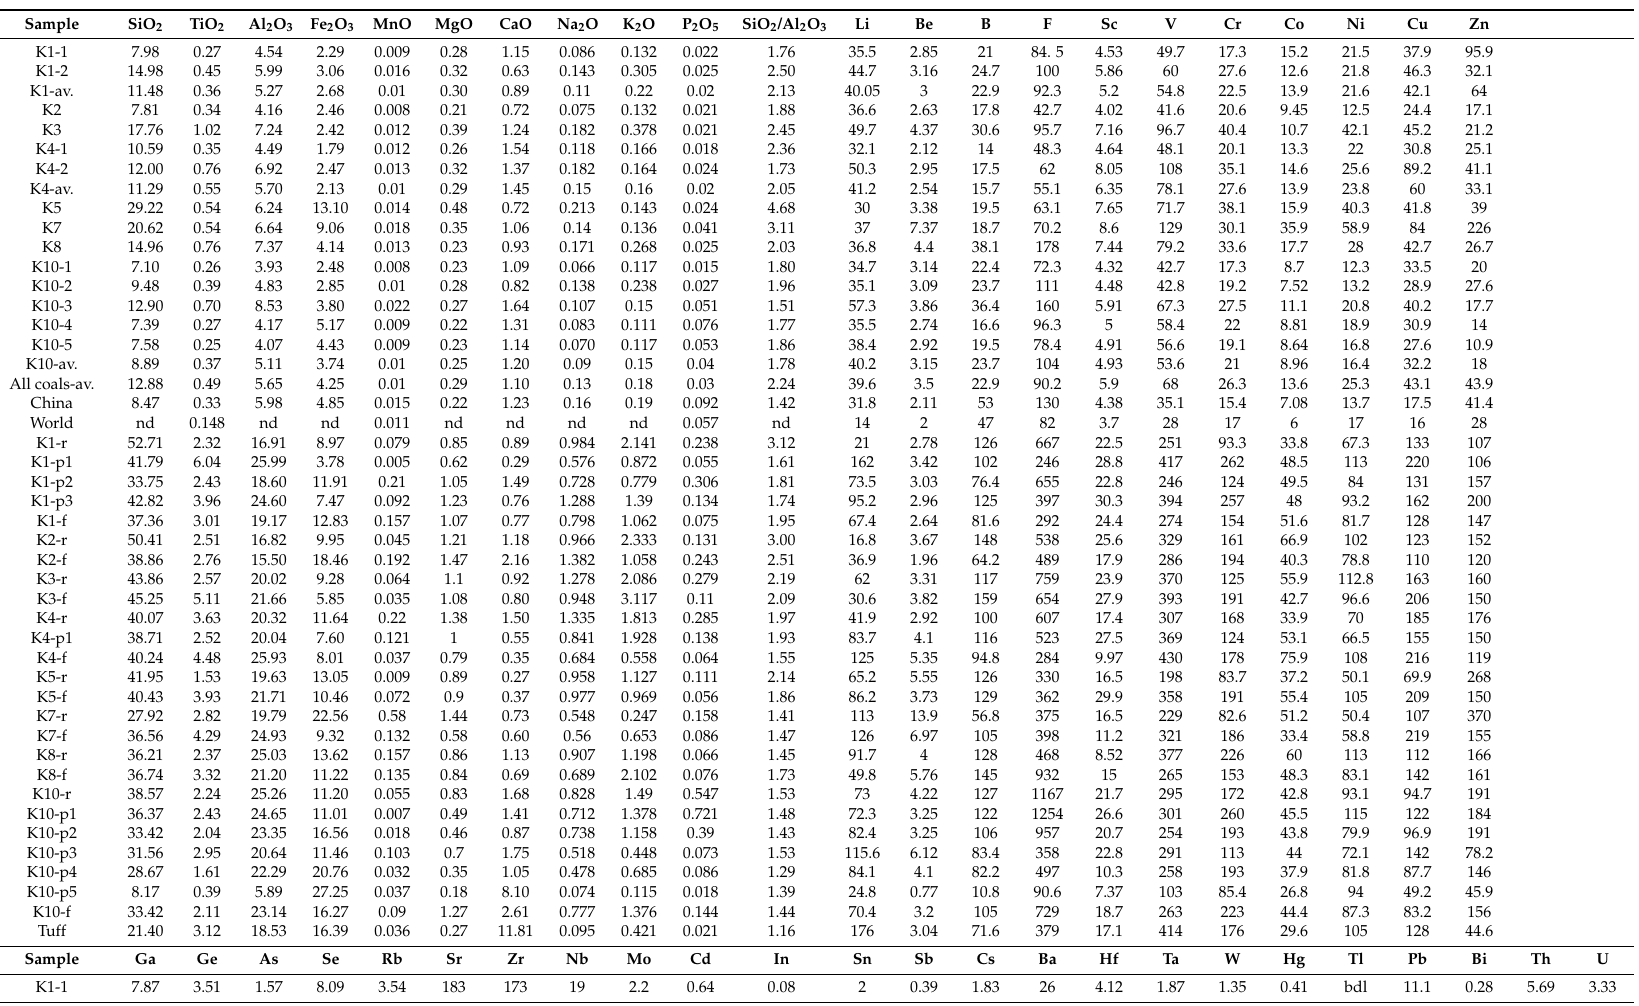
Table 3. Major element oxides (%) and trace elements in the coal and non-coal samples from the ZK4-1 drill core in the Zhongliangshan Coalfield ( µ g/g).